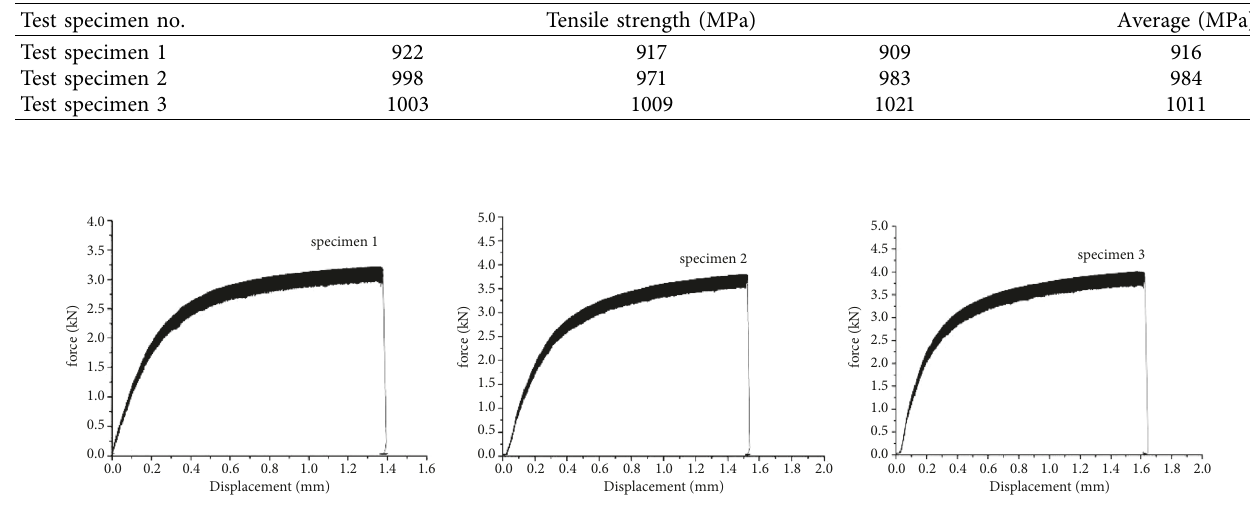
Figure 7: Stress-strain curves of the three specimens: specimen 1 (cross-sectional area: 3.50mm 2 ); specimen 2 (cross-sectional area: 3.82mm 2 ); specimen 3 (cross-sectional area: 4.00 mm 2 ).